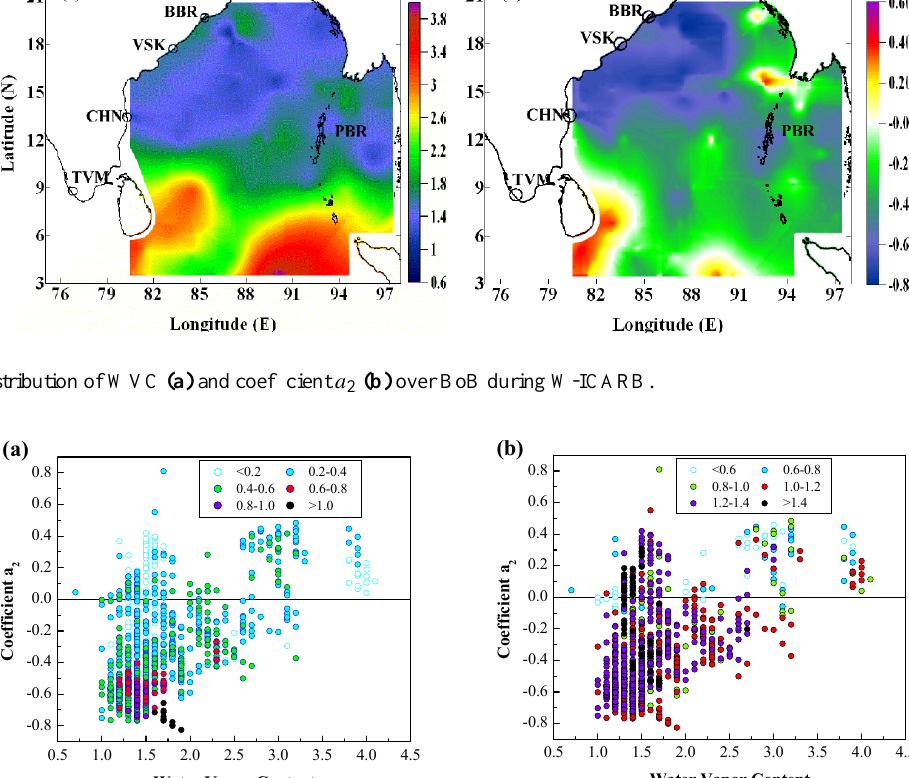
fraction under higher humidity levels underlying